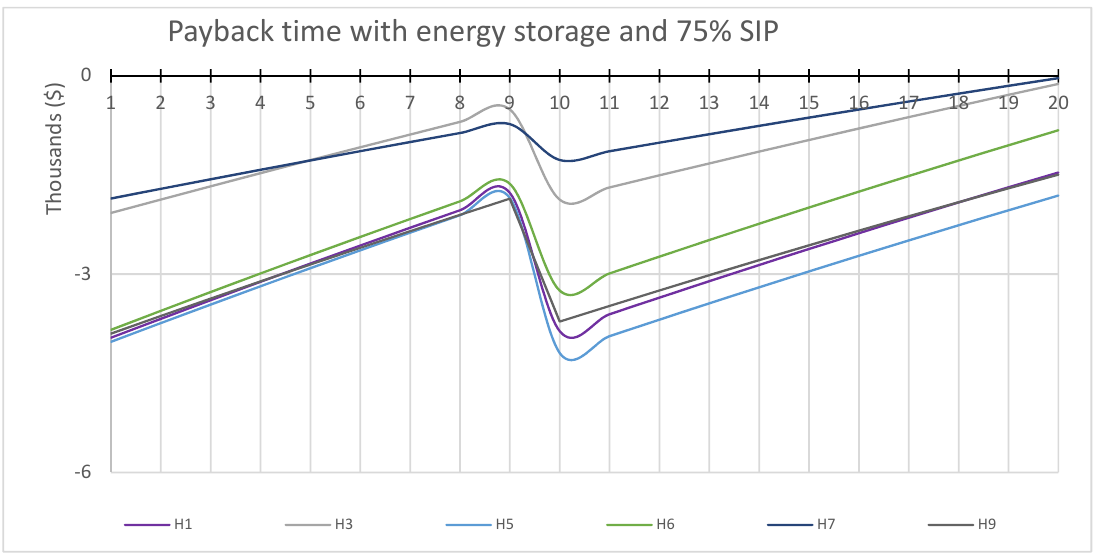
Figure 13. Economic model results demonstrate the payback time for the rooftop PV systems with energy storage and 75% SIP for houses H1, H3, H5, H6, H7, and H9.